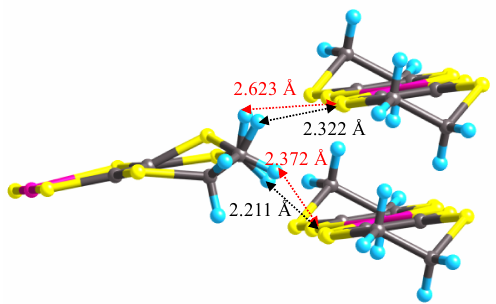
Figure A1. Two distinct CH-S hydrogen bonds by the positional disorder.